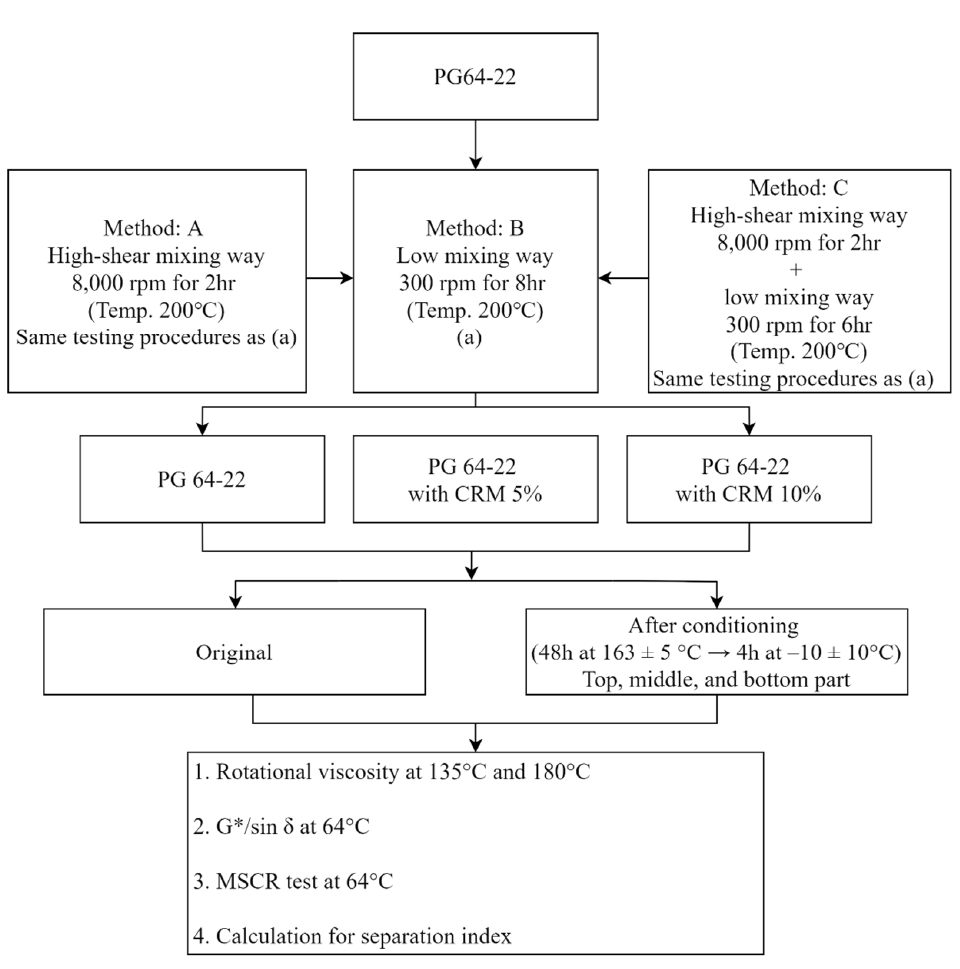
Figure 2. Flow chart of experimental design procedure in this study.